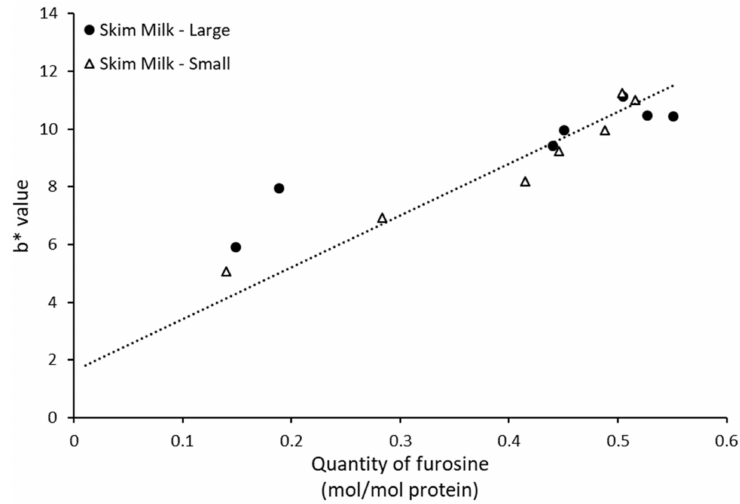
Figure 4. Relationship between b* value (yellow-blue scale, positive values indicates yellowness) and level of furosine in UHT-treated skim milk, representing milk pools with either large or small casein micelles, as developed during the 6-month storage period at 40 ◦